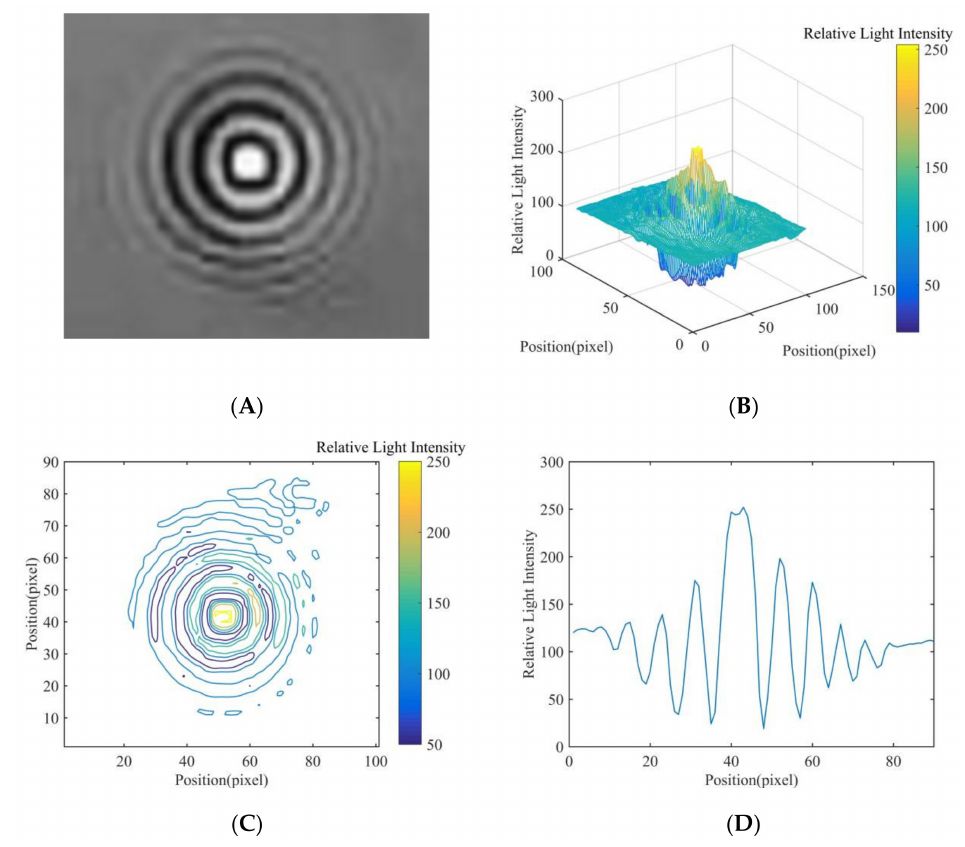
Figure 7. Results of B. cinerea spore fingerprint image processing, ( A ) diffraction image, ( B ) three- dimensional relative light intensity distribution, ( C ) two-dimensional relative light intensity distribu- tion, and ( D ) relative light intensity distribution value. Table 1. Statistical results of the relative light intensity distribution of diffraction fingerprints of three kinds of fungal